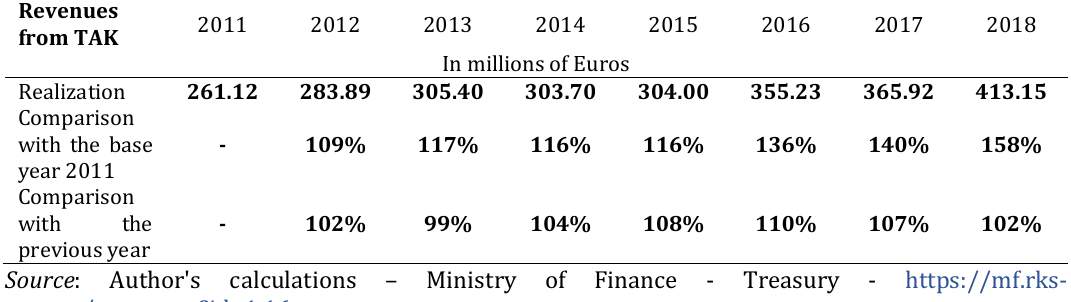
Table 1: Revenues from the Tax Administration of Kosovo in the period 2011-2018 Revenues from